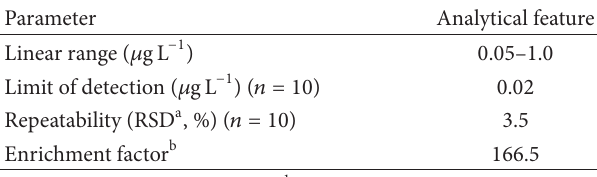
T 2: Analytical characteristics of proposed method. T 3: Determination of Pd(II) in different water